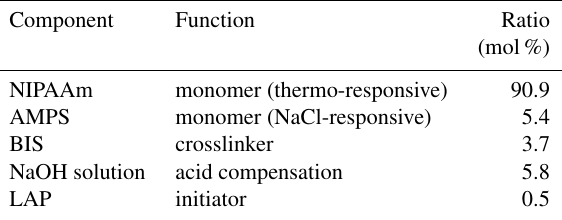
Table 1. Composition of components that are used for polymerisa- tion. The first three form the hydrogel and constitute